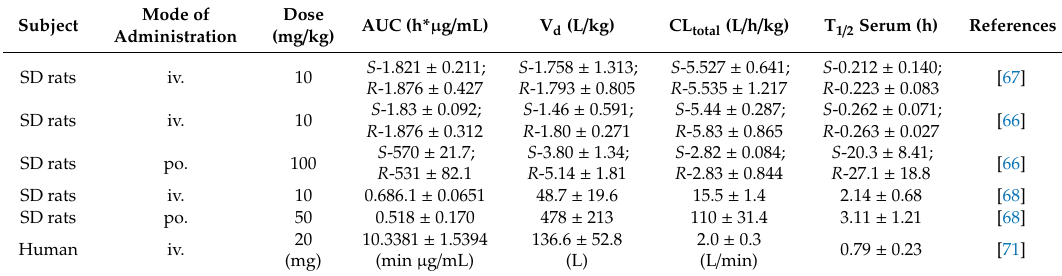
Table 1. Summarizes the PK parameters of